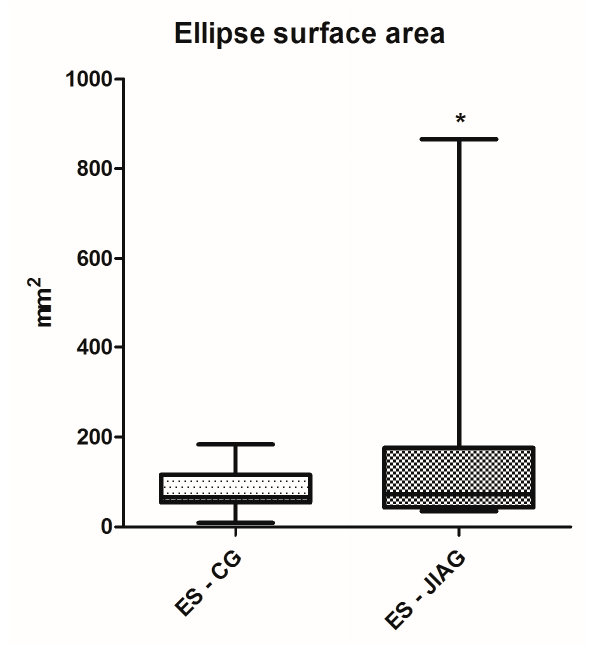
Figure 2. Analysis of ellipse surface area (ES) of the centre of pressure (CoP) among the group of healthy subjects (CG) and subjects with juvenile idiopathic arthritis (JIAG). * indicated that p < 0.05. Int. J. Environ. Res. Public Health 2017 , 14 , 806